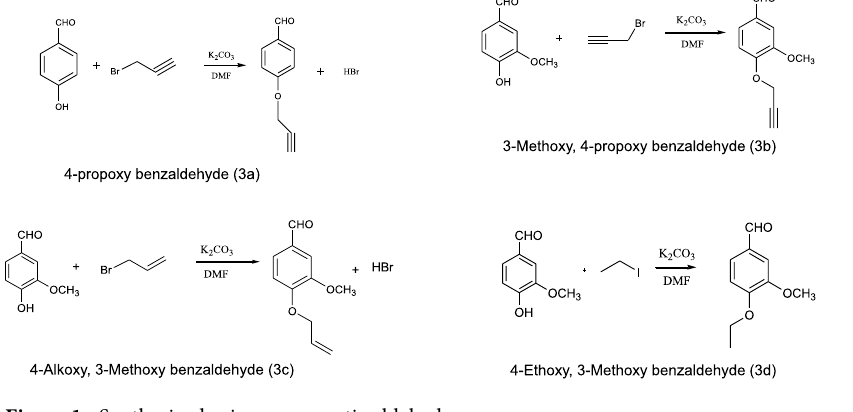
Figure 1. Synthesized primary aromatic